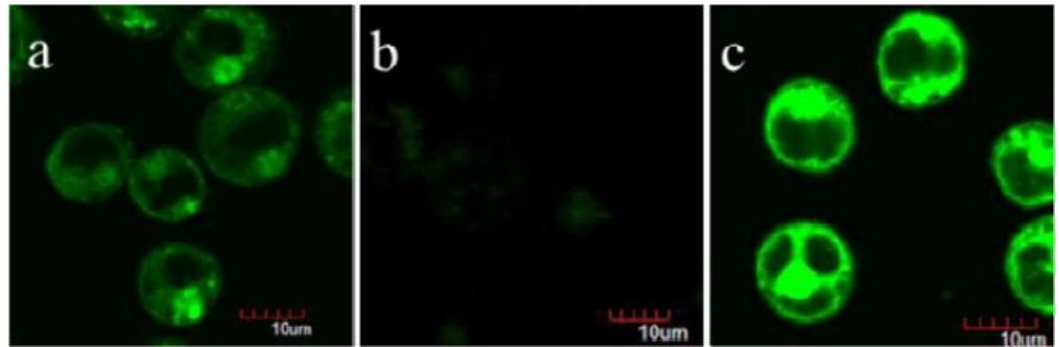
Figure 9. Two-photon confocal microscopy (CM) images of glutathione detection in living CEM cells. ( a ) CEM cells incubated with the TP-MSN@MnO 2 nanoparticle; ( b ) CEM cells pretreated with